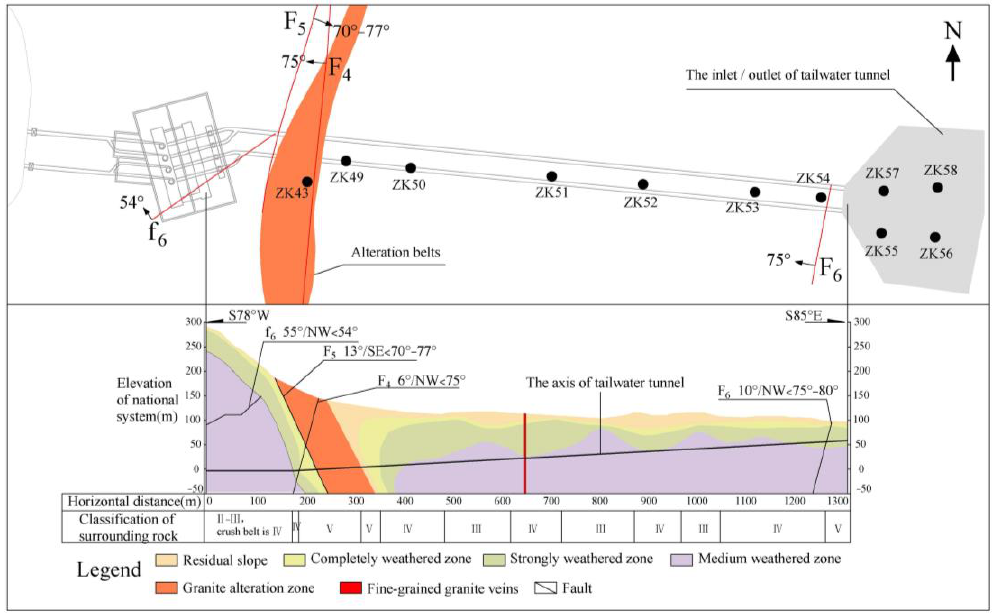
Figure 3. Geological structure and drilling layout of engineering area.